Question: Express in one sentence what the figure is showing.
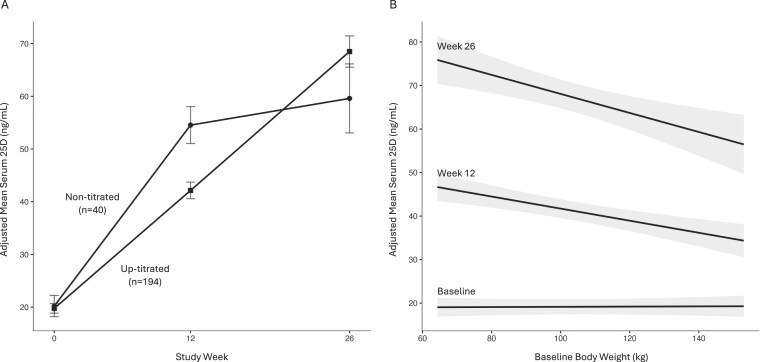
Answer: Achieved serum 25-hydroxyvitamin D (25D) concentrations by dose titration status and baseline body weight during 26 weeks of treatment with extended-release calcifediol (ERC). (A) Adjusted mean serum 25D concentrations over time in non-titrated or up-titrated participants. Points represent adjusted means and error bars indicate 95% CIs. (B) Adjusted mean serum 25D concentrations as a function of baseline body weight among up-titrated participants ( n = 194). Shaded bands denote 95% CIs.